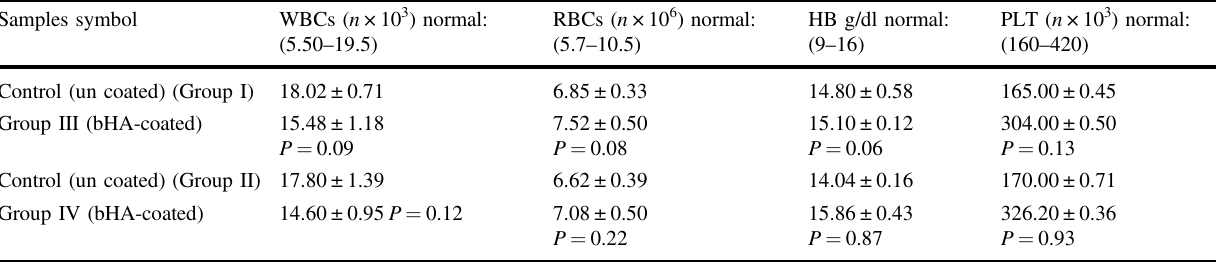
Table 2 Toxicity effects on RBCs, WBCs, hemoglobin, and PLT count at T0 Samples